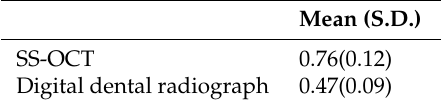
Table 3. Diagnostic agreement with CLSM (weighted